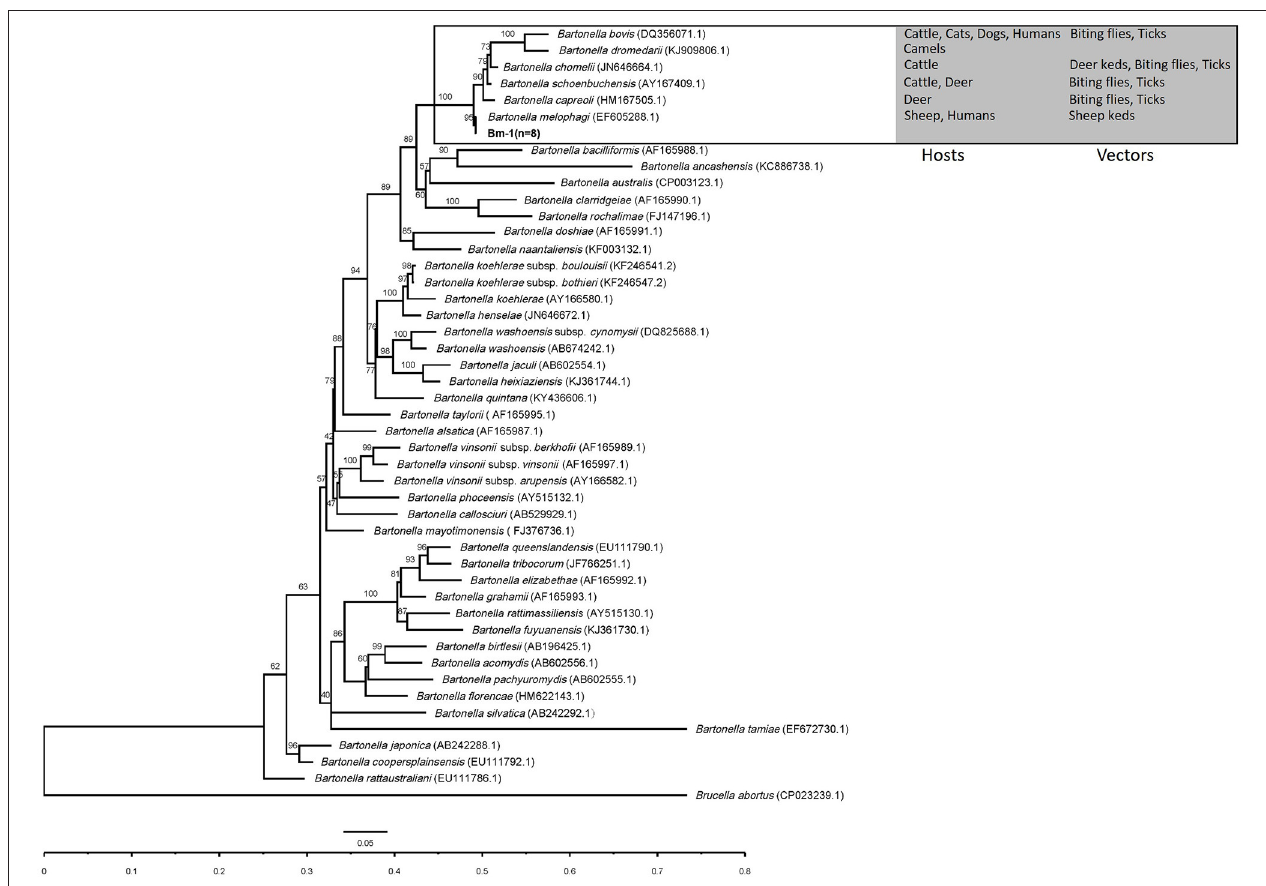
FIGURE 3 | The phylogenetic tree of Bartonella rpoB sequences was constructed by using maximum likelihood (ML) and HKY + I + G4 + F as evolutionary models. The sequences detected in this study are shown in bold, and the numbers at the nodes correspond to bootstrap values. Brucella abortus was used as the out